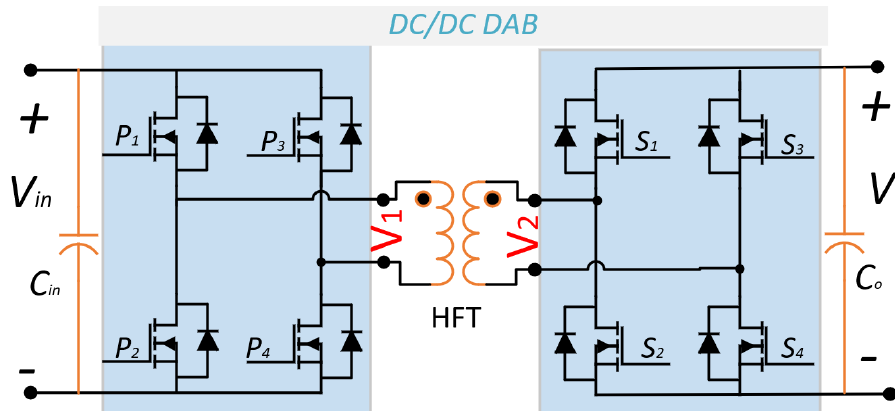
Figure 1. DAB converter.